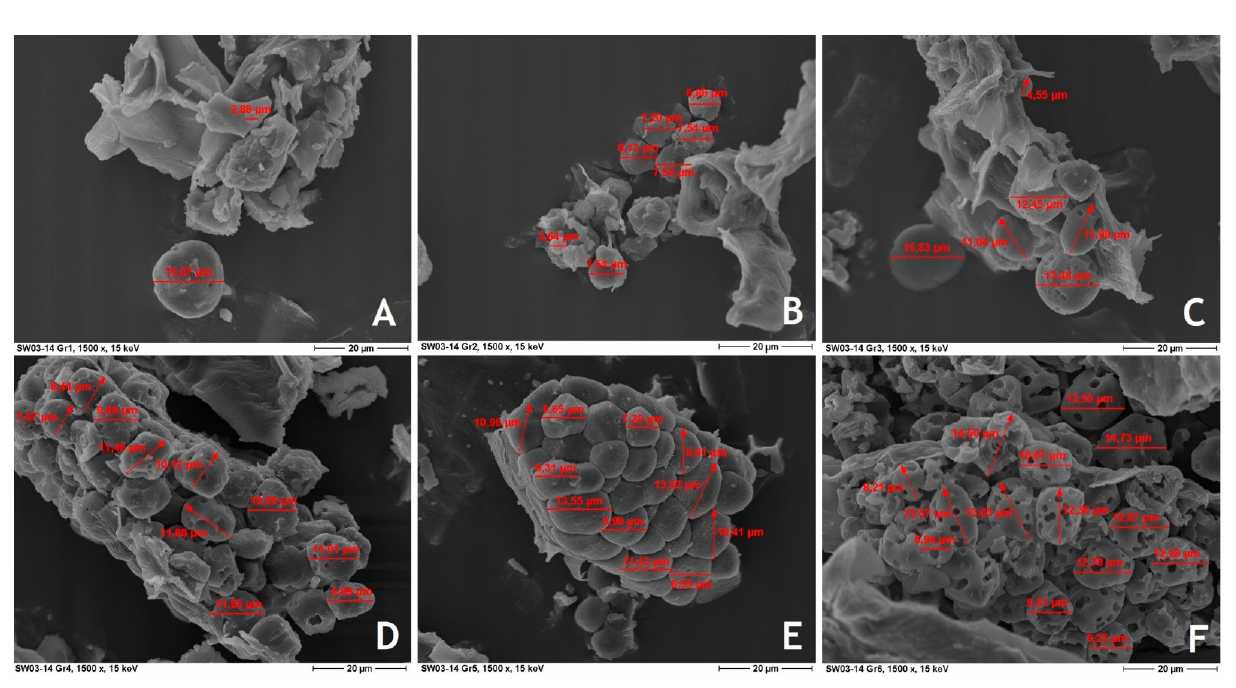
Figure 3. Electronic scanning microscopy (ESM) picture from starch granules of ileal broiler chyme ( × 1500) (( A ) coarsely ground non-compacted; ( B ) coarsely ground and pelleted; ( C ) coarsely ground, expanded and pelleted; ( D ) finely ground non-compacted; ( E ) finely ground and pelleted; ( F ) finely ground, expanded and pelleted).